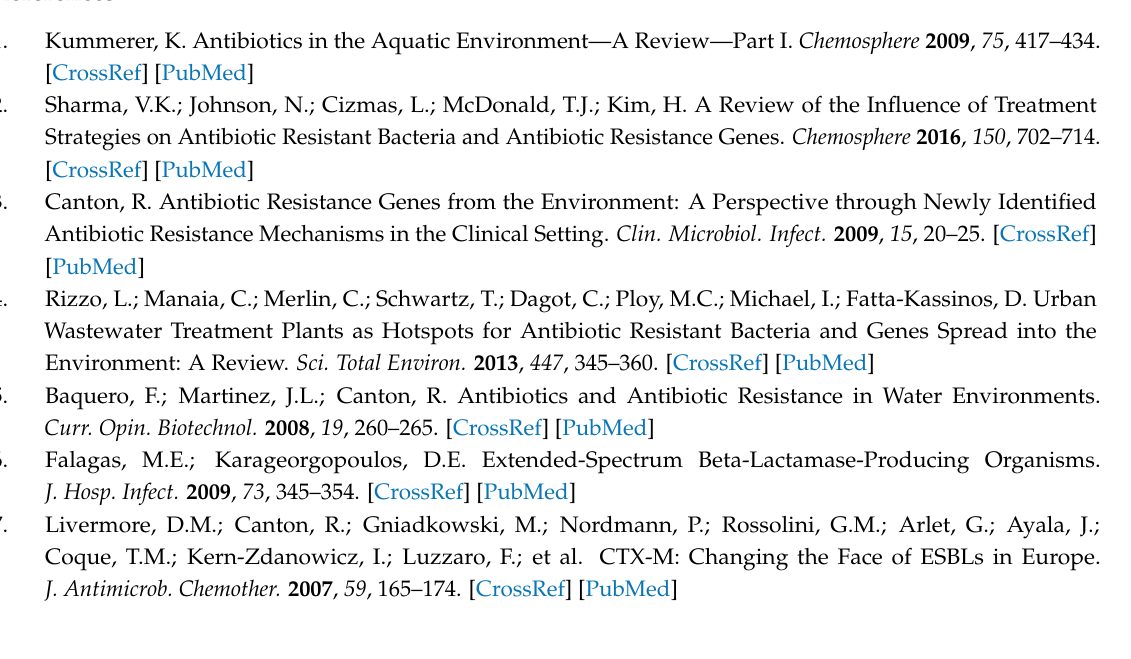
Table S1: Antibiotics, disk content and breakpoints used for disk susceptibility testing according to the EUCAST guidelines (EUCAST V2.0,